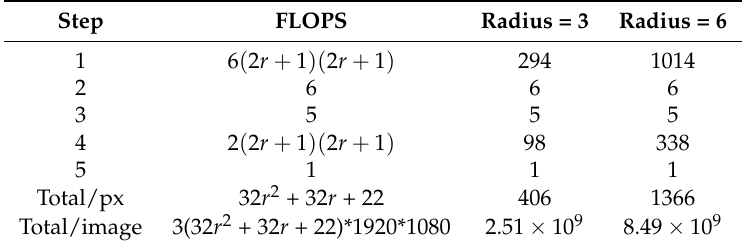
Table 2. FLOPs calculation for a full-HD RGB image with radii r = 3 and r =